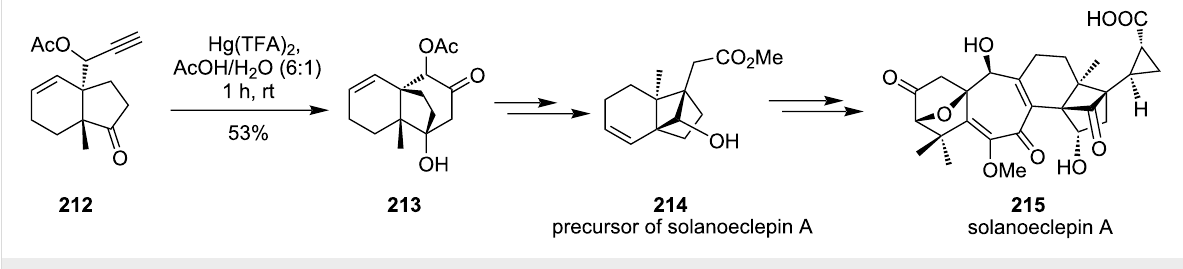
Scheme 64: Total synthesis of solanoeclepin